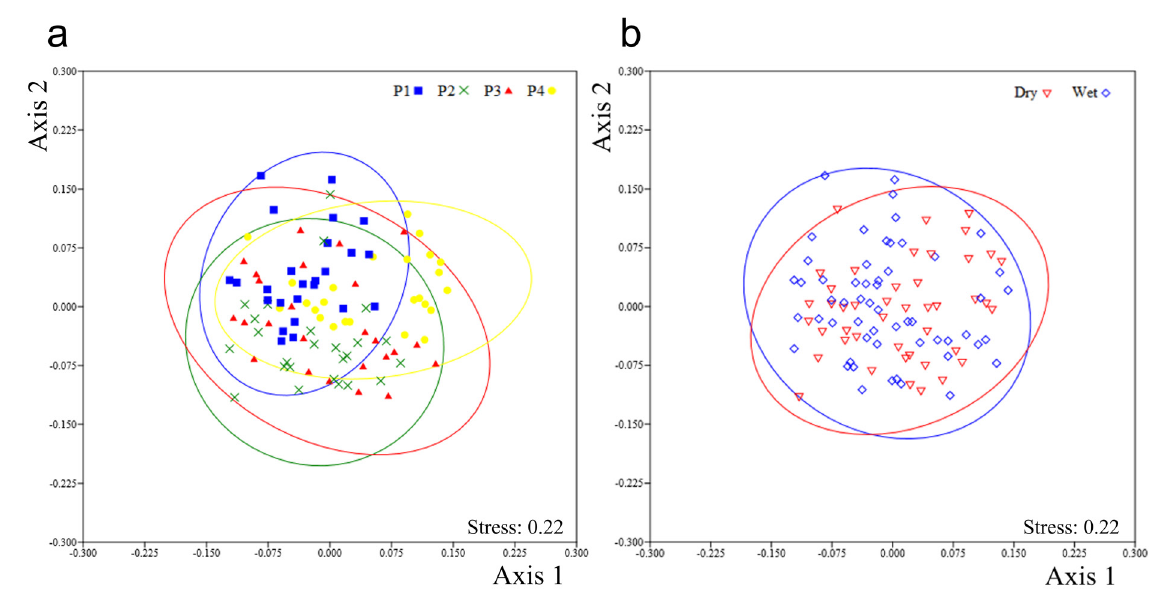
Figure 6. nMDS of the mean density of species associated to Mytilopsis leucophaeata per sampling site (a) and per season